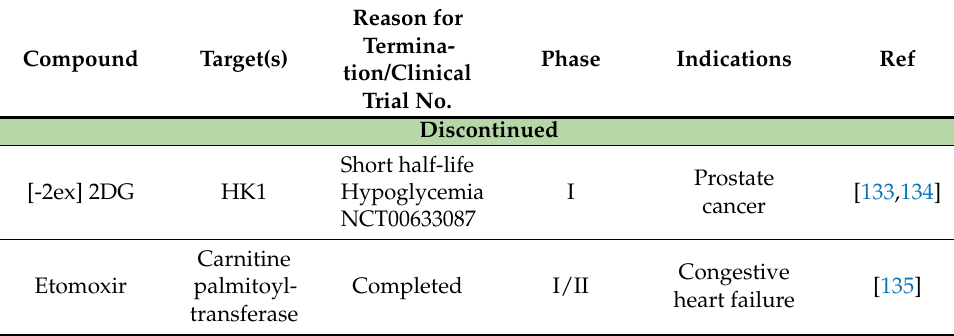
Table 1. Summary of metabolic drug targets and related clinical trials. AML: acute myeloid